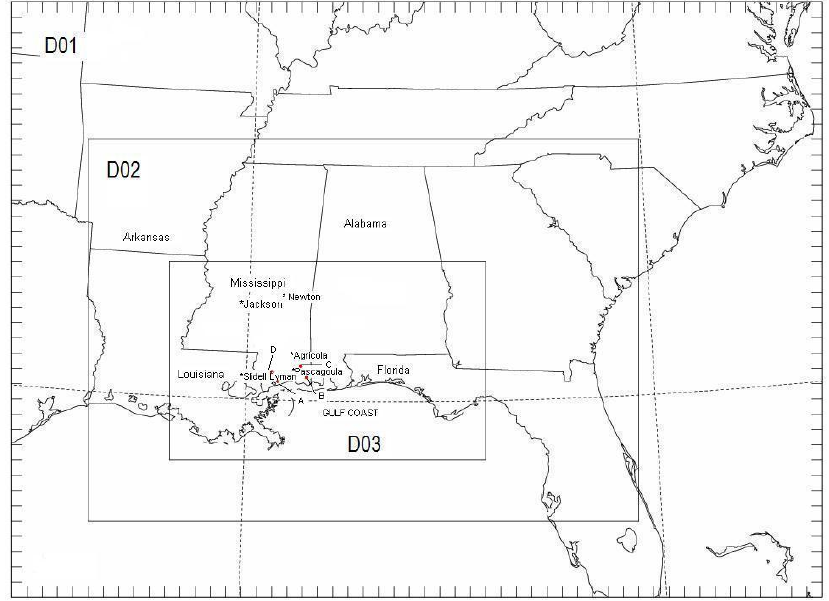
Figure 1. Location of the study area Mississippi Gulf coast and the domains used in the WRF model